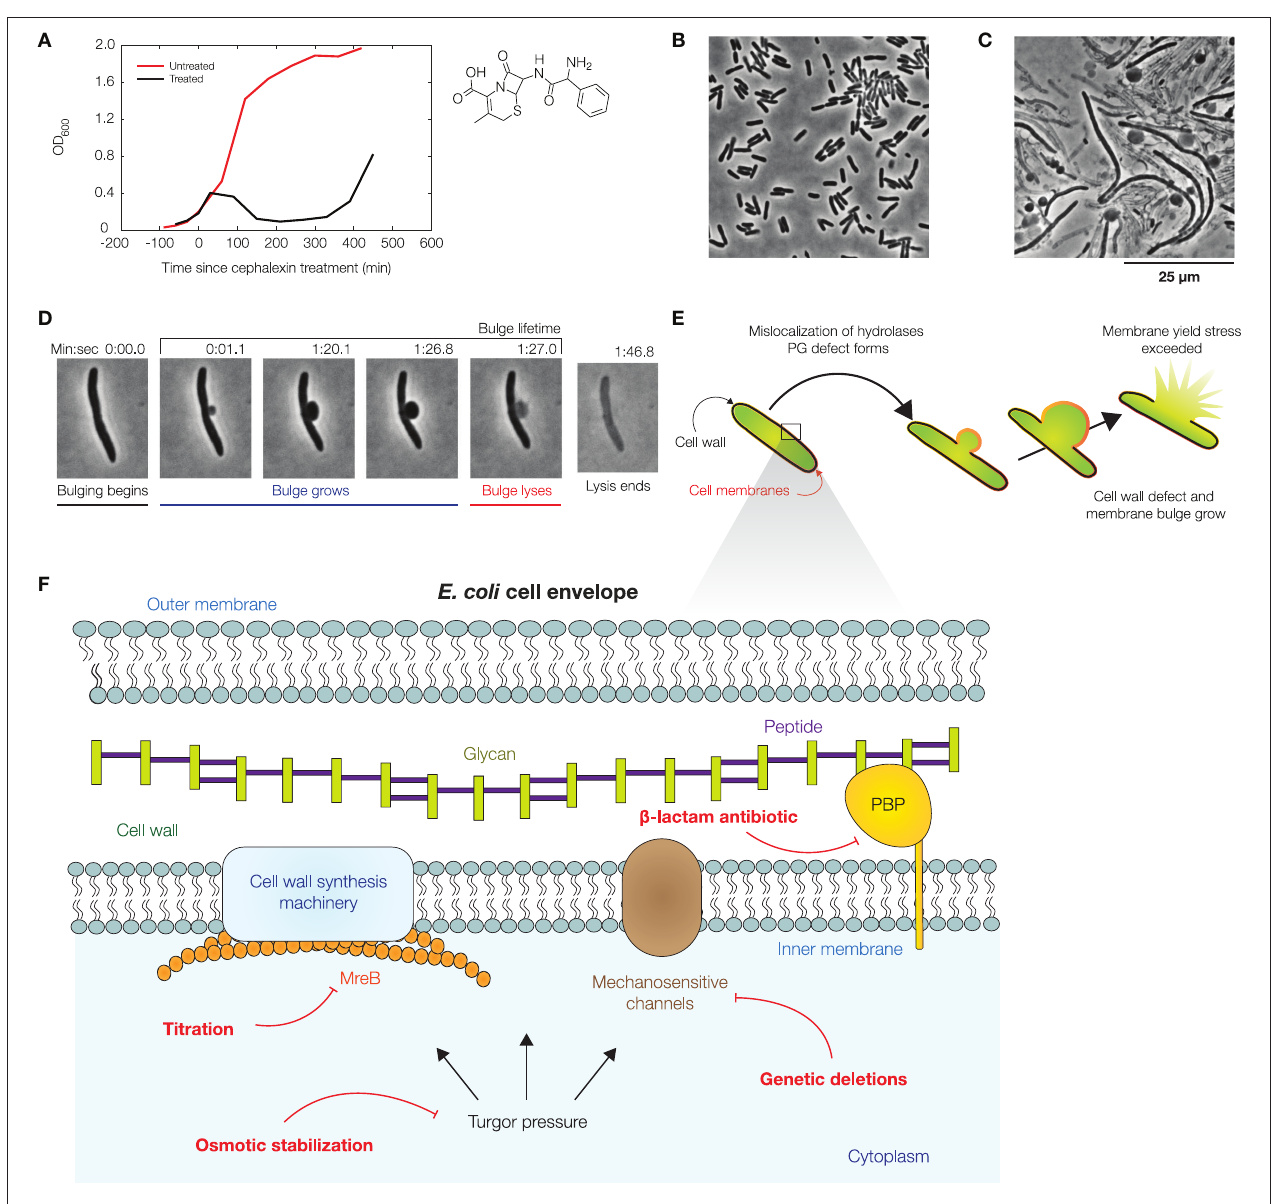
FIGURE 1 | Dynamics of bacterial cell lysis. (A) Representative optical densities (OD 600 ) of a culture of wild-type Escherichia coli (strain MG1655) treated by cephalexin (50 µ g/mL), as shown at right. For comparison, measurements for an untreated culture are shown in red. Each curve shows one of two similar biological replicates. (B) Phase-contrast image of a population of E. coli cells immediately after cephalexin treatment. For a full timelapse, see Supplementary Movie 1 . (C) Phase-contrast image of the same population 2 h after cephalexin treatment, illustrating that membrane bulging and lysis are common within a population. For control experiments, see Supplementary Figure 1 . (D) Lysis dynamics of a representative log-phase E. coli cell during cephalexin treatment (50 µ g/mL), in which the cell membrane bulges and lyses. For a full timelapse, Supplementary Movie 2 . (E) Schematic of a mechanical model which predicts the dynamics of membrane bulging and lysis. In this model, bulging arises due to membrane reorganization and the relaxation of the cell envelope, and swelling is caused by the continued growth of cell wall defects. Lysis occurs upon reaching a yield stress in the bulge. See section 4 for details of the model. (F) Illustration of the E. coli cell envelope, with